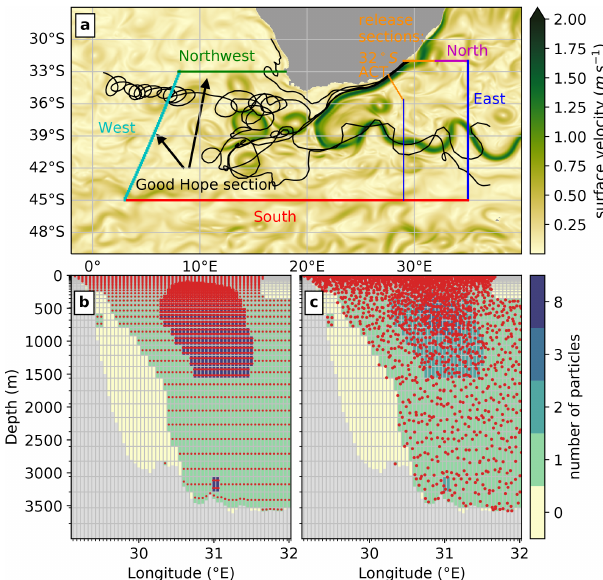
Figure 1. Design of the Lagrangian experiments A, P and P-ACT: (a) release section 32 ◦ S for A and P and release section ACT for P-ACT in orange and all sampling sections as thick lines for A and P and as thin lines for P-ACT if differing from A and P. Exemplary trajectories of experiment P are shown as black lines as well as a snapshot of the surface velocity on 3 January 2010 as simulated in INALT20. Note that the sections “West” and “Northwest” are only an approximation of the locations of the observations at the Good Hope section. Release positions of particles (shown as red dots) in experiment (b) A and (c) P with a shading of the number of parti- cles per grid cell. These particles were released at 12:00UTC on 3 January 2010 in experiment P and in experiment A if only 1 par- ticle was released per grid cell. If eight particles were released per grid cell in experiment A, four of them were released at 06:00UTC on 2 January 2010 and the other four at 18:00UTC on 4 January 2010 from the same positions. In (b) and (c) the grid lines show the model grid and the grey shading the bathymetry with its partially filled grid cells at the